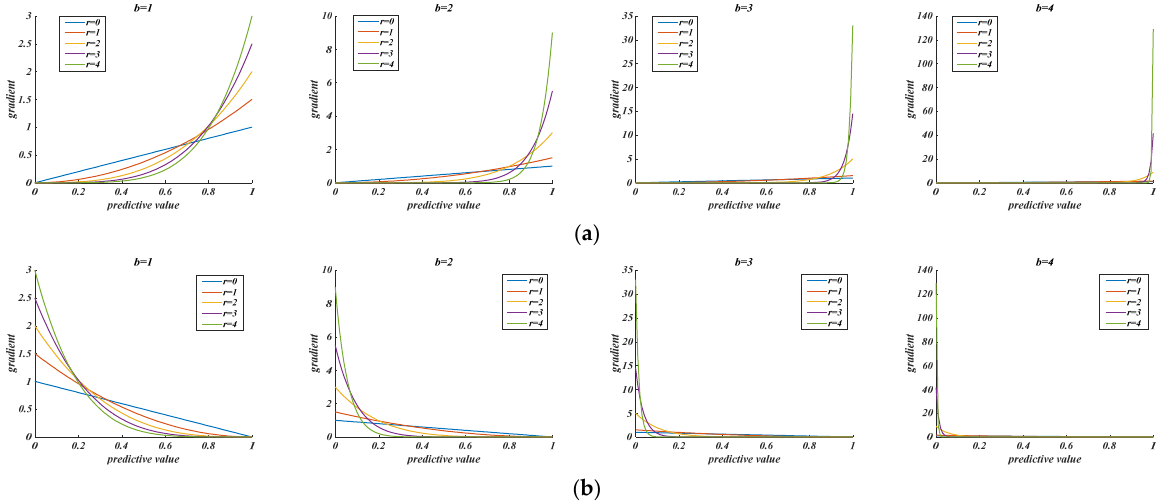
Figure 5. Derivative variation of loss function. ( a ) Positive sample; ( b ) Negative sample.